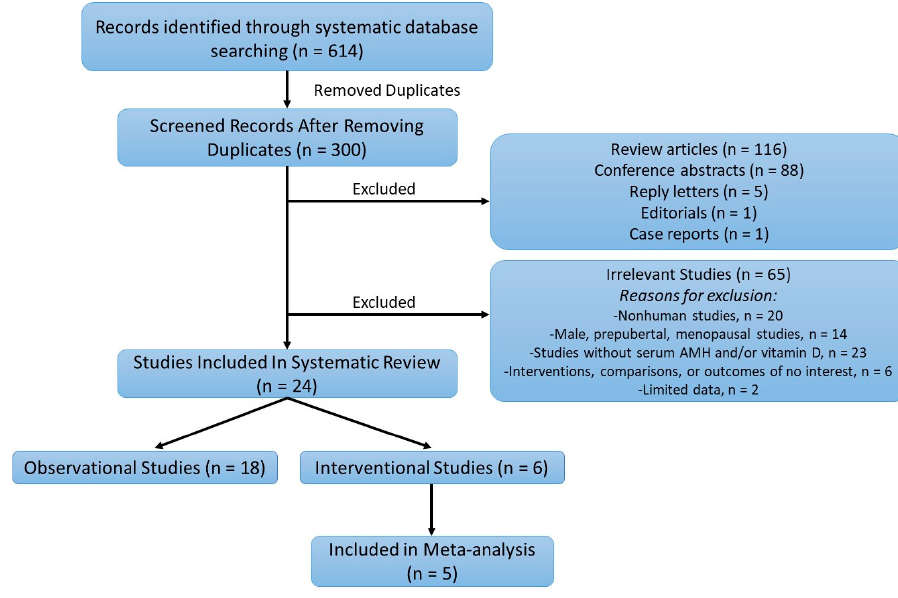
Figure 1. Flowchart of the systematic literature search strategy and results. AMH: anti- Figure1. Flowchartofthesystematicliteraturesearchstrategyandresults. Müllerian hormone.